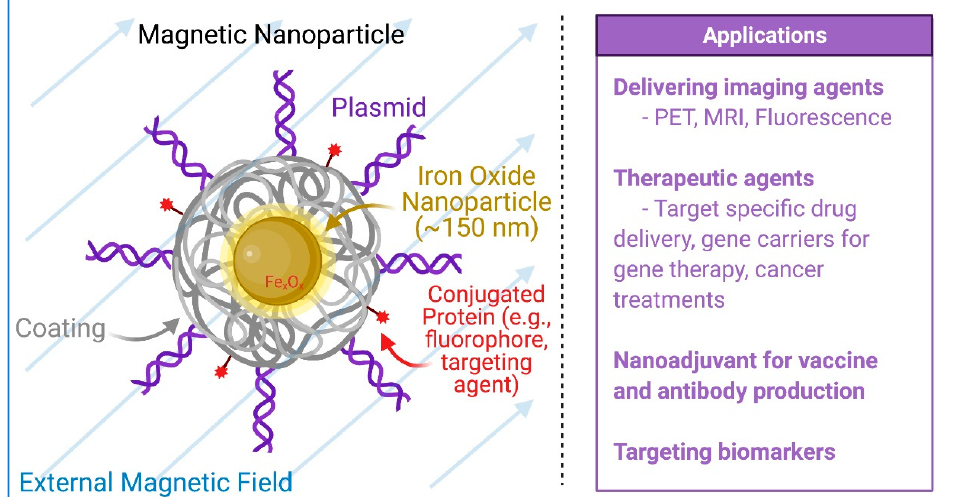
Figure 4. Iron oxide nanoparticles and applications. Iron oxide nanoparticle under an external magnetic field (light blue lines) with internal magnetic diploe aligned. For biological applications, nanoparticles are coated with an inorganic or organic coating, often to bind or contain other molecules for biological use. Figure generated using BioRender.